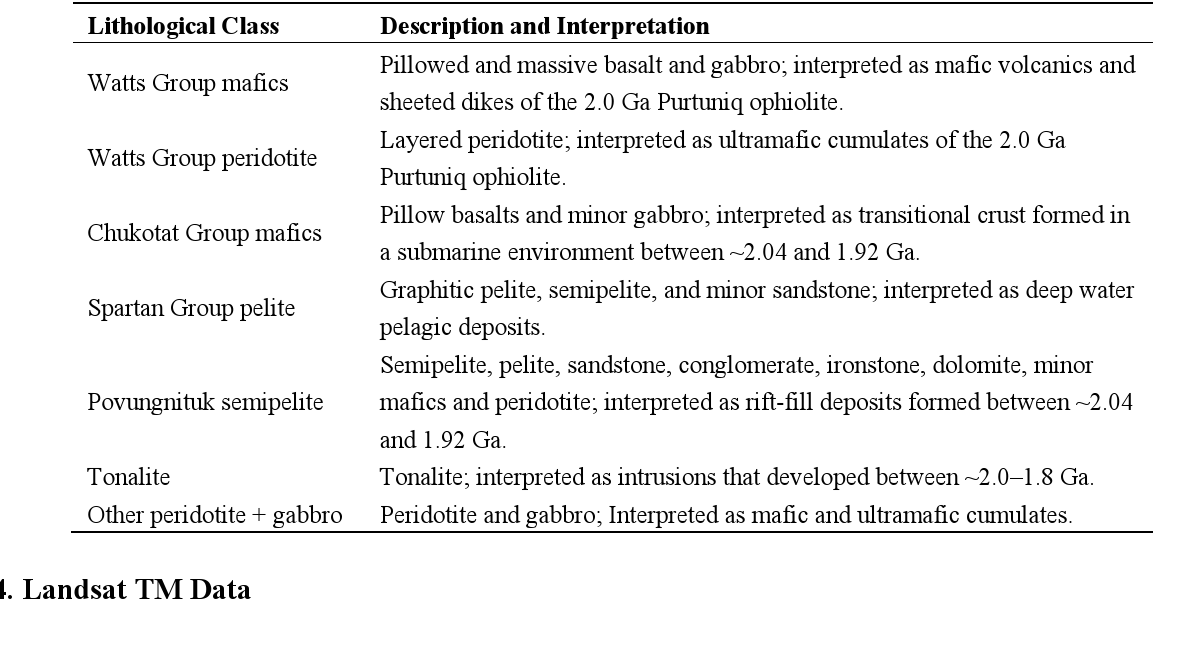
Table 1. Lithological classes of the central Cape Smith Belt region (after [38]). All classes have been metamorphosed to between greenschist and amphibolite